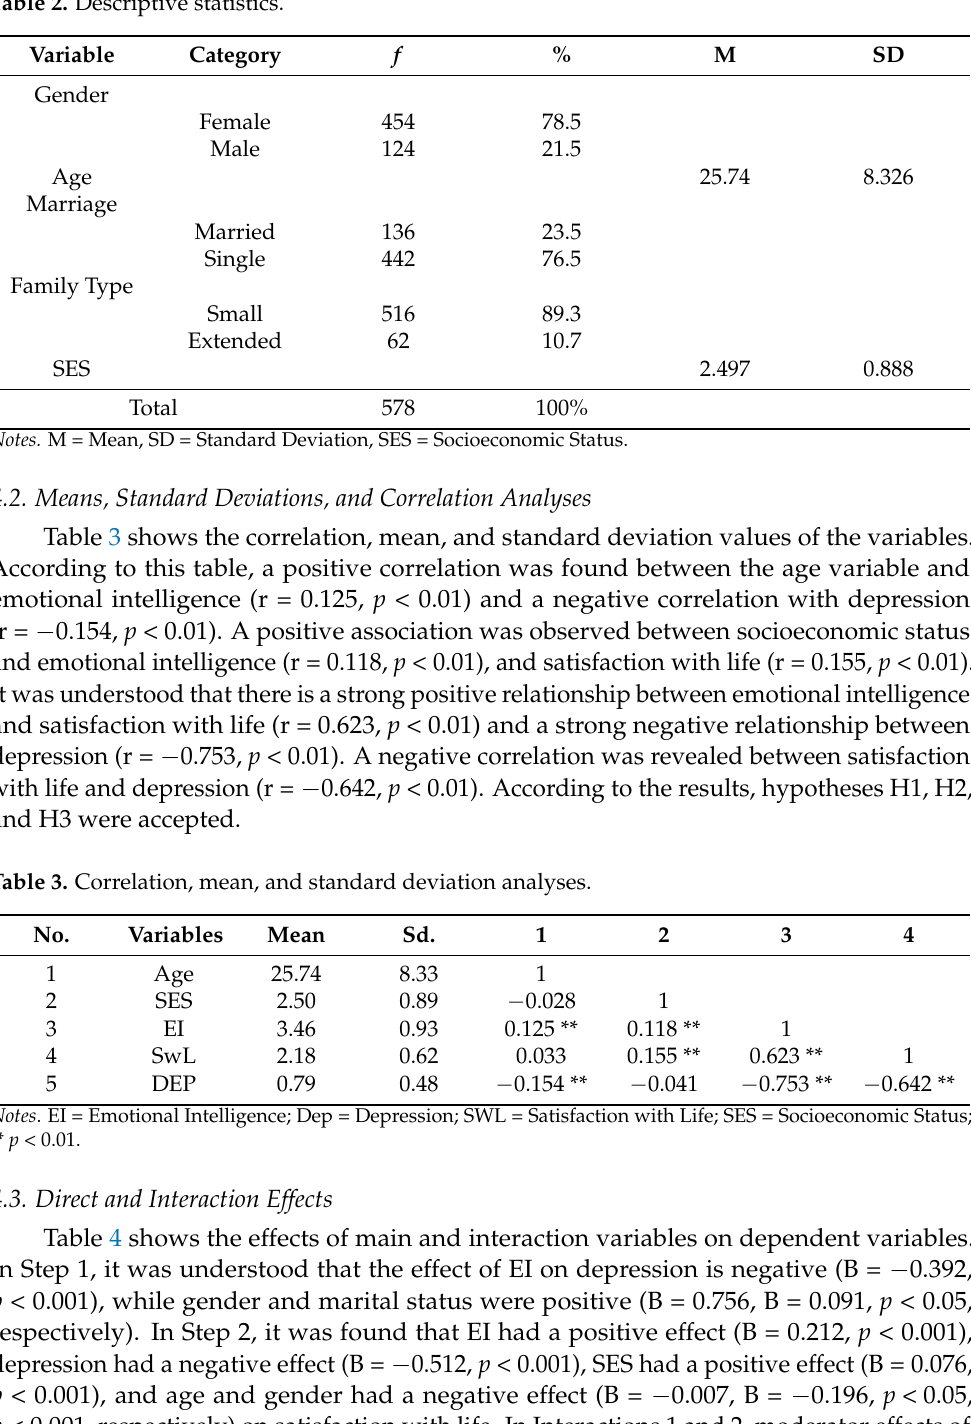
Table 2. Descriptive statistics.